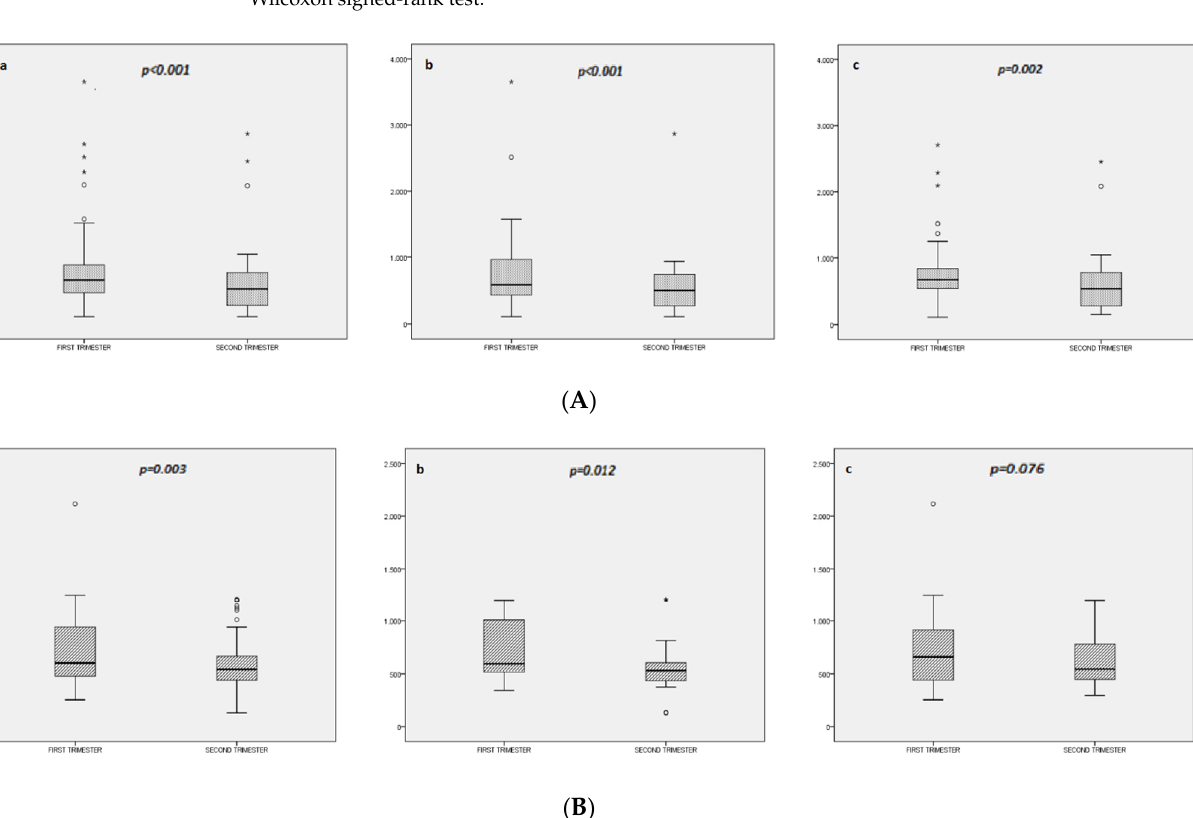
MDPs: Mitochondria-derived peptides. Related-sample comparisons across trimesters were per- formed by the Wilcoxon signed-rank test.